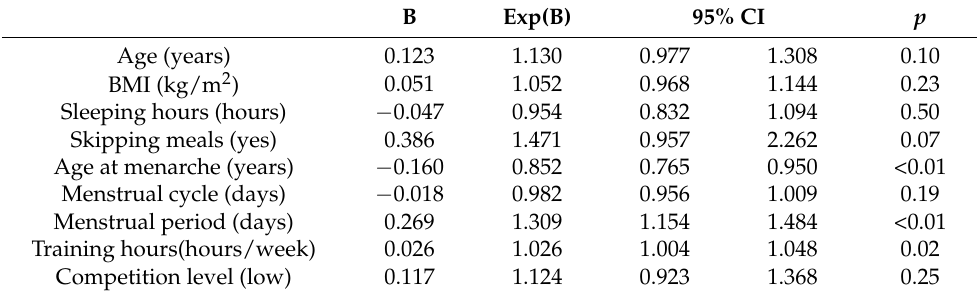
Table 4. Factors related to the severity of dysmenorrhea in athletes.